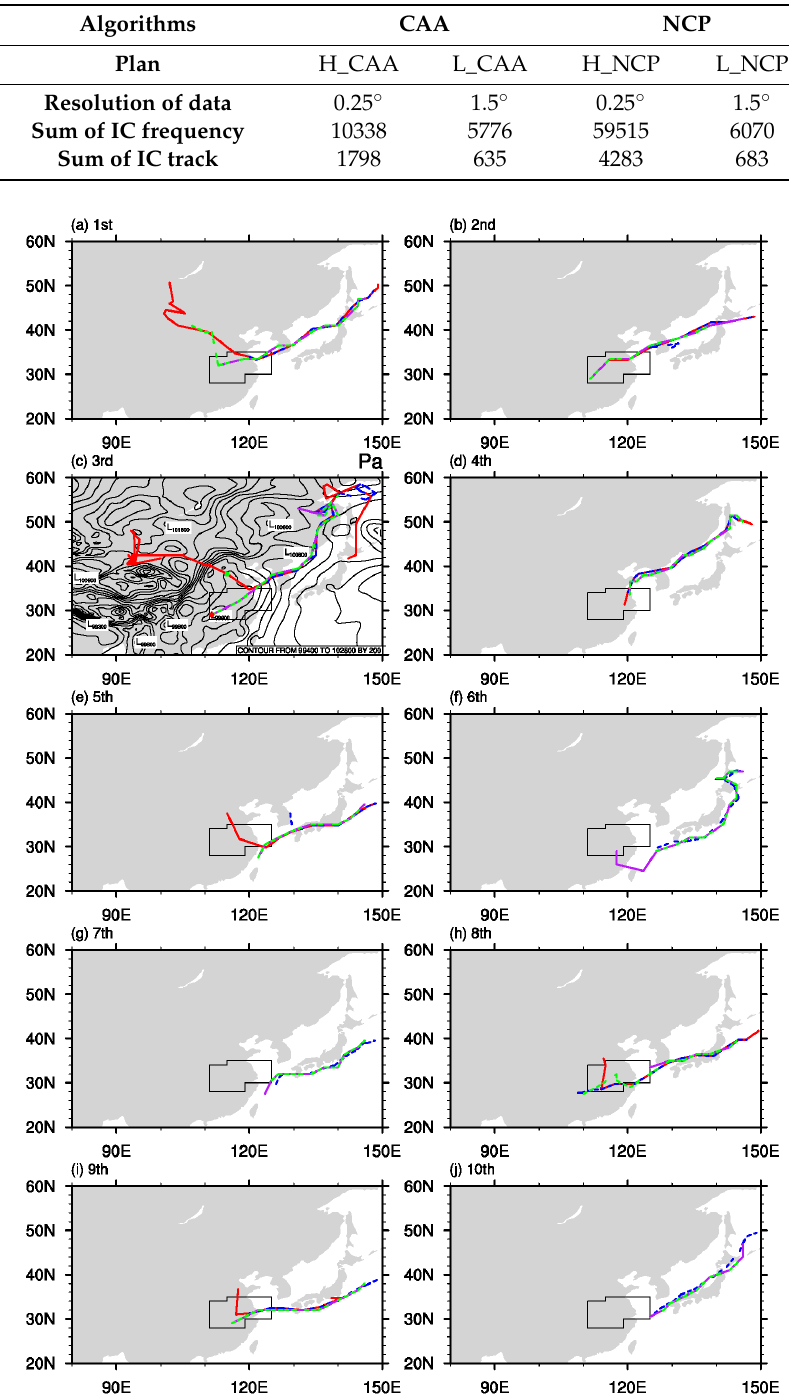
Figure 6. The tracks of the ten lowest center-SLP ICs for the four schemes in Table 4 (red solid line: H_NCP; purple solid line: L_NCP; blue dashed line: H_CAA; green dashed line: L_CAA). Contours in Figure 6c denote the SLP field for 12 UTC, 25 May 1980 (interval of 1.4 hPa) and the green (red) lines denote the local SLP minimums without (with) a closed contour.